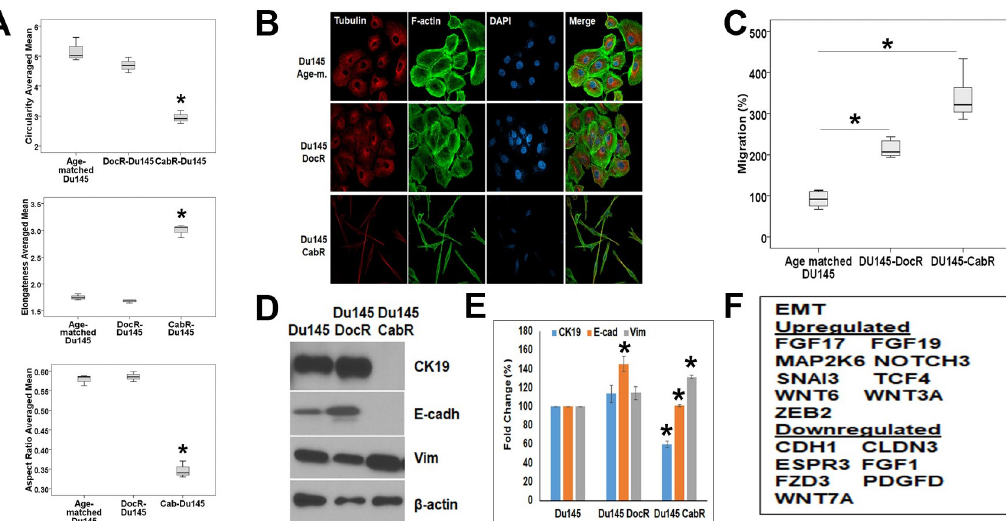
Fig 3. Genotypic and phenotypic characterization of the taxanes resistant Du145 cells (A) Cell morphological study looking at the cell circularity (Top), elongatedness (Middle), and aspect ratio (Bottom). Statistical analyses were performed using the Welch and Brown-Forsythe tests followed by the Games-Howell test, � p < 0.05. (B) Cell morphology analyses showing the distribution of tubulin (Red staining) and F-actin (Green staining) in Du145 age-matched, DocR, and CabR. Nuclei are visualized by DAPI staining (Blue). (C) Migration of the age-matched, DocR and CabR cells using the Inverted Boyden Chamber in vitro assay. Migration of the age-matched cells was used as the 100% migration control. Each cell line was tested in quadruplicate and the experiments were repeated three times. (D) Protein expression level of Epithelial (Cytokeratin 19 and E-cadherin) and Mesenchymal (Vimentin) specific markers. Beta-actin was used as a protein loading control. (E) Protein expression quantification obtained from three separate western blotting experiments. Decreased E-cadherin and CK19, and increased vimentin proteins in CabR cells when compared to the age-matched or DocR cells were all found statistically significant. Statistical analyses were done using a t-test. (F) mRNA expression profile of Epithelial and Mesenchymal specific markers.